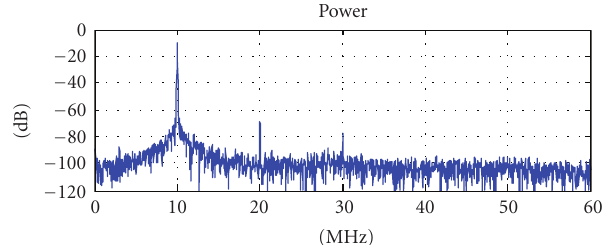
Figure 12: Spectrum output from 130 MHz sine wave input illustrating the low-noise floor of the DCR. Due to the fixed 120 MHz sample rate, the bandpassed signal is aliased to